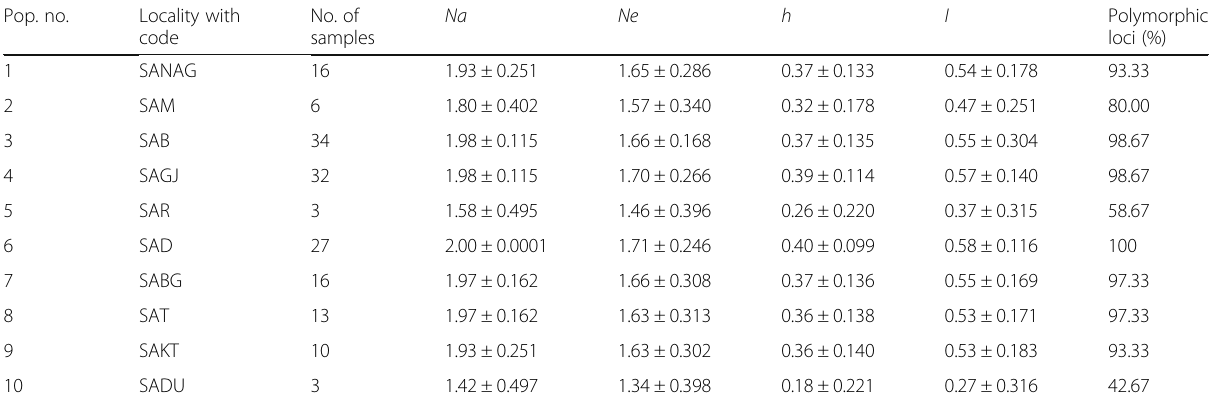
Table 3 Summary of genetic variation statistics among the 160 accessions of S. asoca Pop.